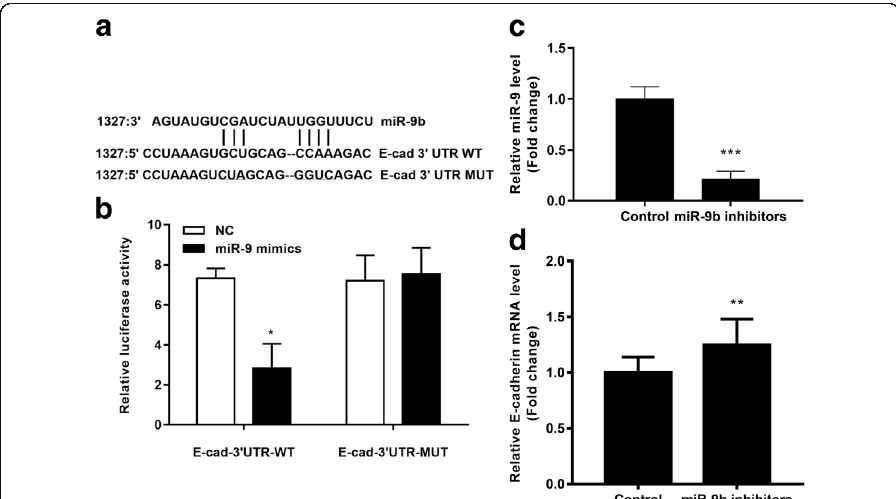
Fig. 4 miR-9 directly targets E-cadherin. a – Bioinformatics prediction of the binding site of miR-9 with E- cadherin 3 ’ UTR. b – The relative luciferase activity of E-cadherin wild-type (WT) or mutant (MUT) 3 ’ UTR in HEK293 cells following transfection with miR-9 mimics. c – Relative expression of miR-9 in A549 cells